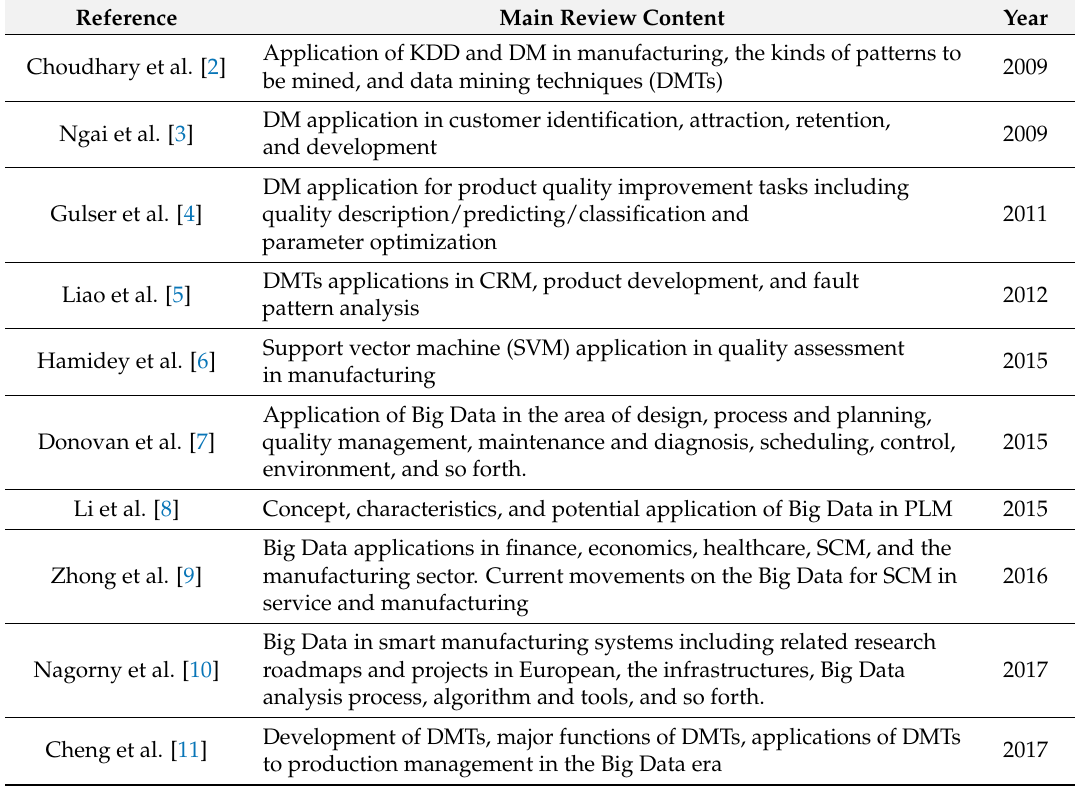
Table 1. The reviews of data mining and big data application in the smart manufacturing